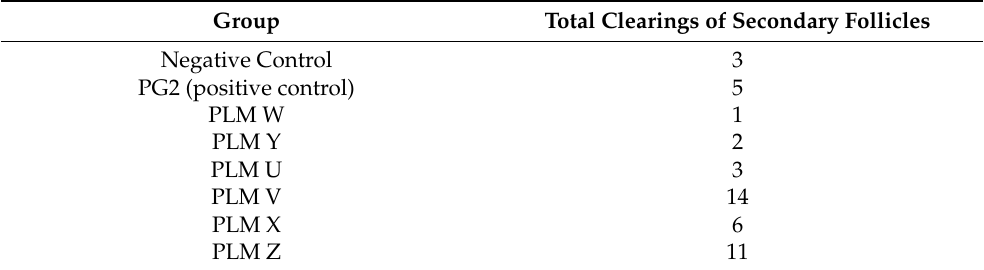
Table 7. Sum of thinning of secondary follicles in the respective M. agalactiae infection and con- trol groups.